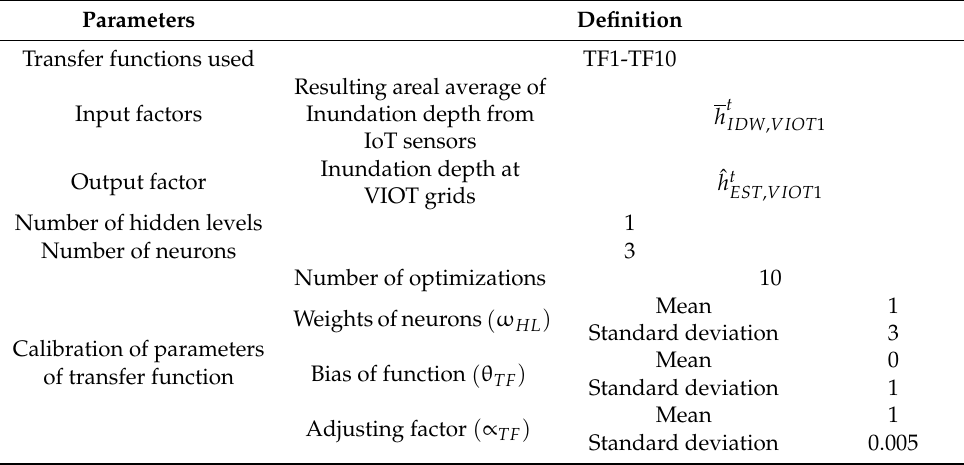
Figure 13. Summary of the estimation of the number of hidden neurons via various methods. Table 4. Settings of the proposed ANN-GA-SA_MTF model.